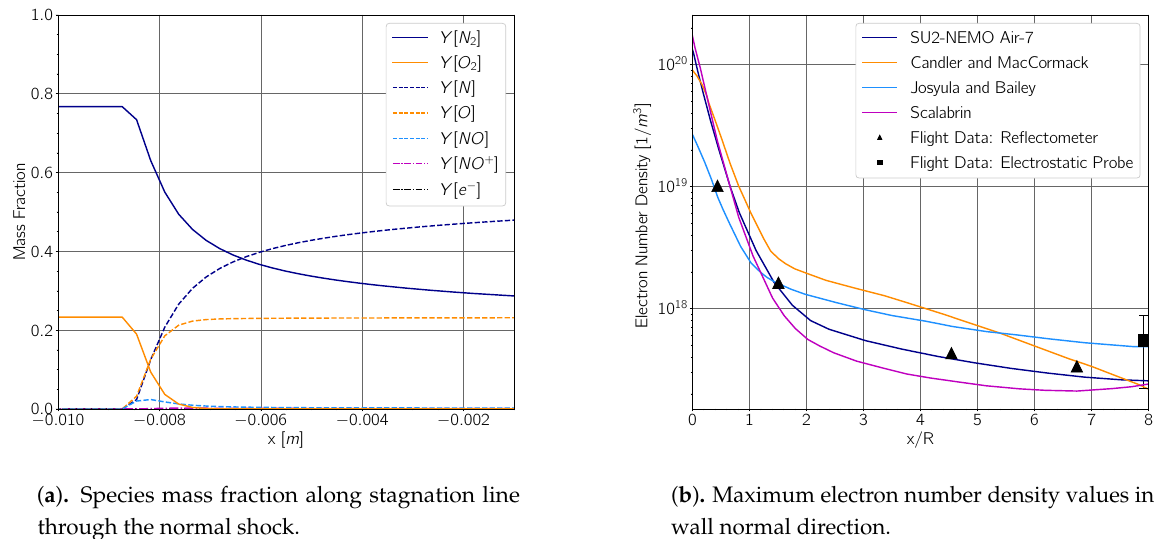
Figure 9. RAM-C species concentrations. Comparison with experimental [50] and numerical [45,51,52] results. In Figure 8a, a strong bow shock that develops at the nose of the vehicle is observed. High temperatures attained across this shock drive chemical reactions, resulting in signifi- cant variation in the flow chemistry along the stagnation line, as illustrated in Figure 9a. Diatomic nitrogen and oxygen are depleted, while concentrations of monatomic oxygen and nitrogen increase. The mass fraction of nitric oxide is relatively small in comparison;